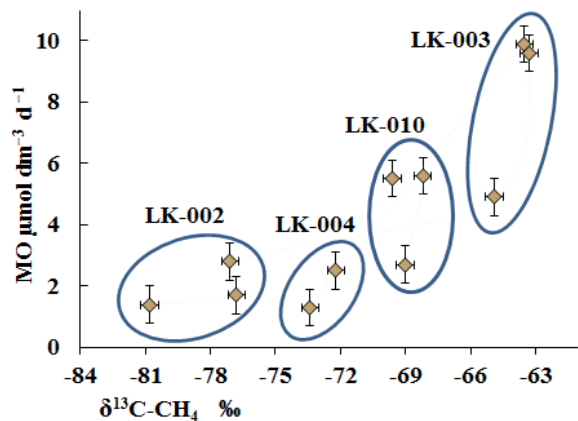
Figure 8. Isotopic composition of methane carbon ( δ 13 C-CH 4 ; ‰) in the bottom sediments of four Yamal lakes and the rates of methane oxidation (MO; µmoldm − 3 d − 1